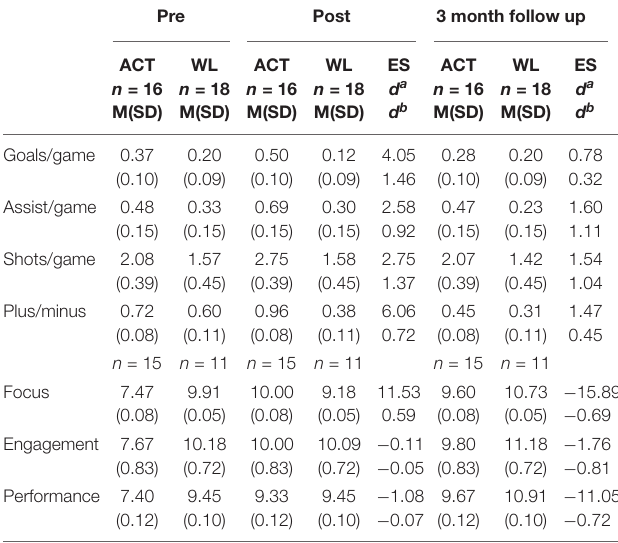
TABLE 1 | Estimated means and standard deviations based on the mixed model repeated measures for game statistics and blinded coach ratings from pre to follow up with effect sizes between groups at post and follow up.